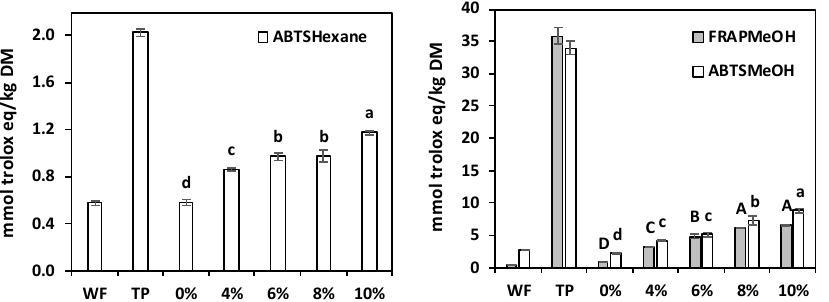
Figure 4. Antioxidant capacity (FRAP and ABTS tests) of the lipophilic extracts (in hexane) and hydrophilic extracts (in 80% methanol) of bread wheat flour (WF), tomato pomace (TP), and crackers prepared with increasing TP percentages. The error bars represent the standard deviation; different letters indicate significant differences ( p ≤ 0.05) among cream crackers.